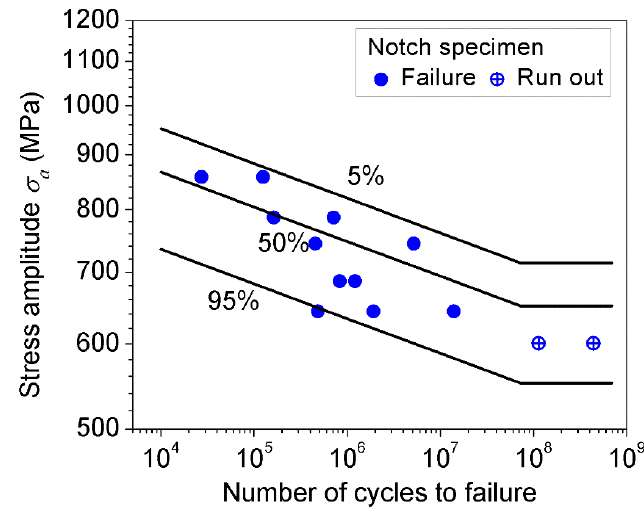
Figure 7. Comparison of predicted P-S-N curves with present experimental data for the notch specimen by using the fatigue strength data of the hourglass specimen